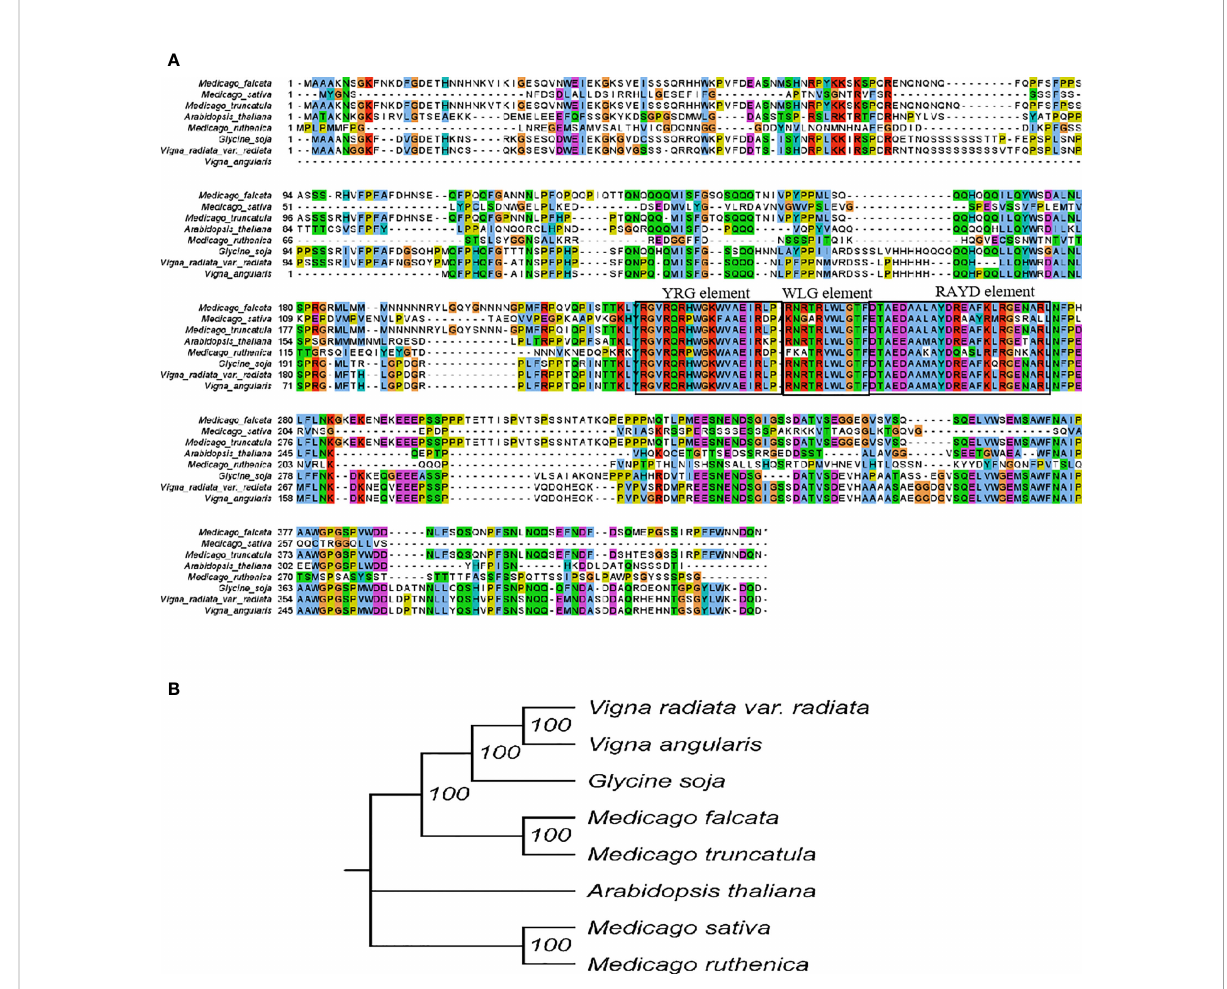
FIGURE 5 Sequence analysis of plant ERF genes. (A) , Multiple sequence alignment. The alignment were constructed by MEGA-X and visualized by Jalview. Residues with more than 50% similarity were shaded. Conserved regions (YRG element, WLG element and RAYD element) were indicated at the top. (B) , Phylogenetic analysis ERF053 genes from different plant